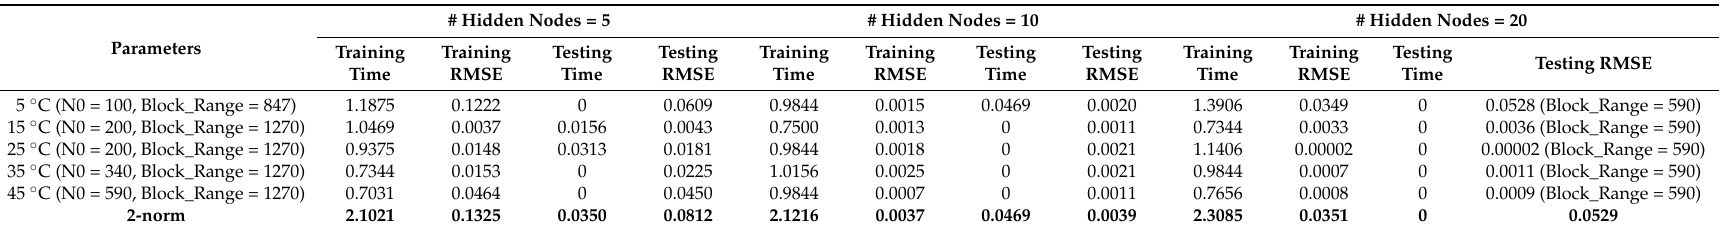
Table 10. Results of adaptive online sequential ELM with sinusoidal activation function (Number of initial training data used, N0 and the range of the size of data block randomly generated in each iteration of sequential learning phase, Block_Range are different).